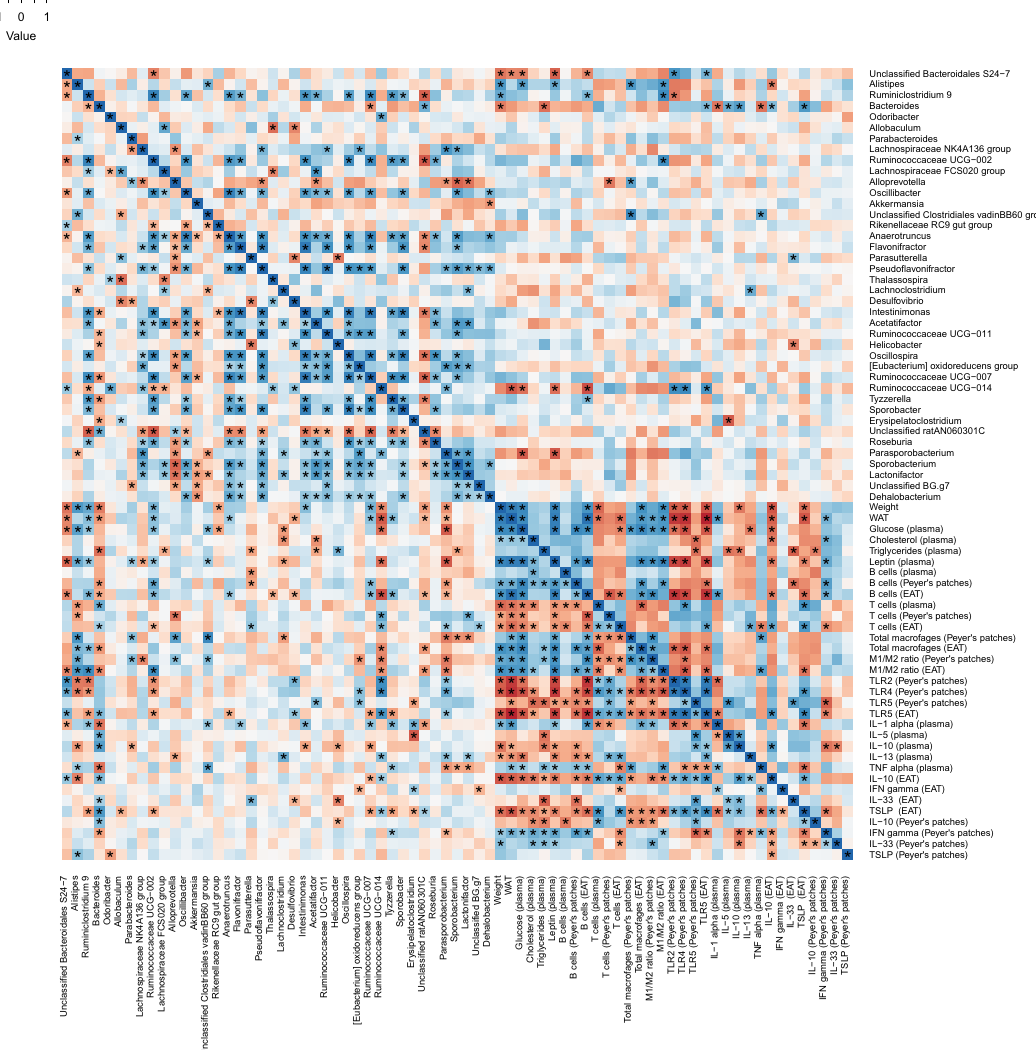
Figure 5. Heatplot of correlations between anthropometric, metabolic, and immune features with the top 50 most abundant gut microbiota taxonomic groups (classified to the lowest taxonomic level). The relative key color indicates the value of Spearman’s correlation coefficient rho (ρ) (blue = positive; red = negative). p values were adjusted with the false discovery rate method for multiple comparisons. Variable pairs that have an “*” below the diagonal line are significantly correlated and pairs with a “*” above the diagonal line are significantly correlated after adjustment of p values for multiple comparisons ( q <